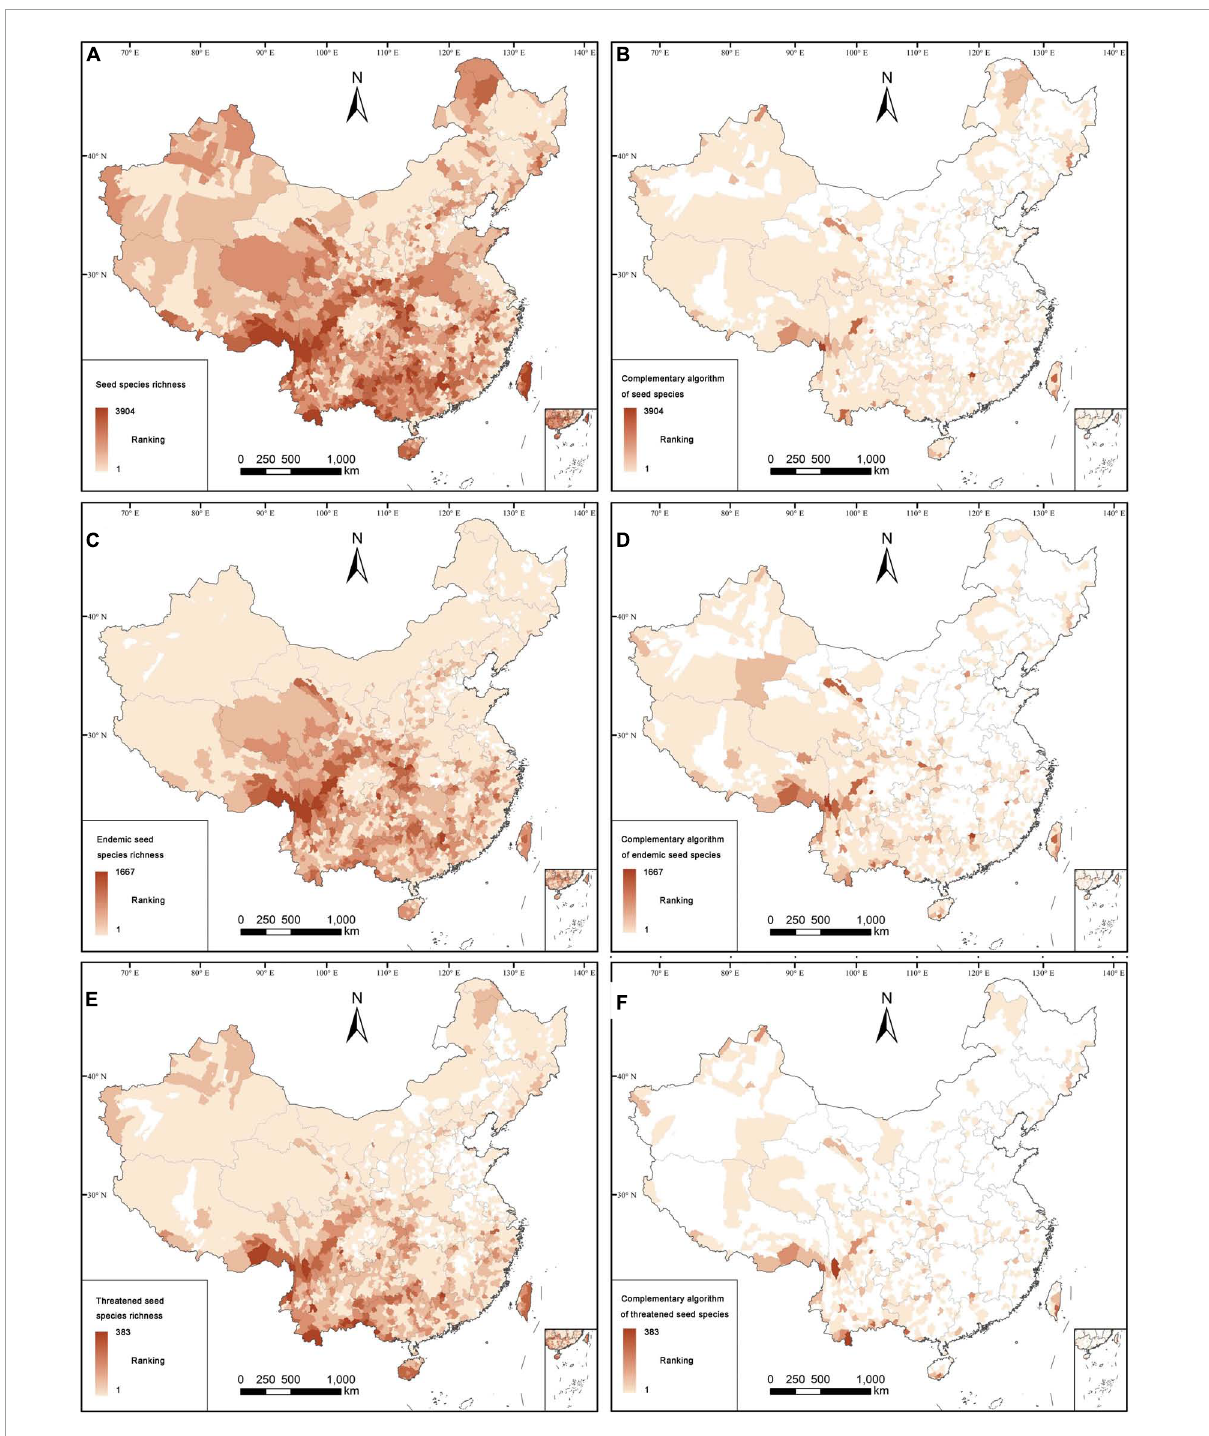
FIGURE1 Distribution patterns of all species (A,B) , endemics (C,D) , and threatened species (E,F) . Counties based on all species are determined by (A) the species richness algorithm, (B) the complementary algorithm; Counties based on endemic species are determined by (C) the species richness algorithm, (D) the complementary algorithm; Counties based on threatened species are determined by (E) the species richness algorithm, (F) the complementary